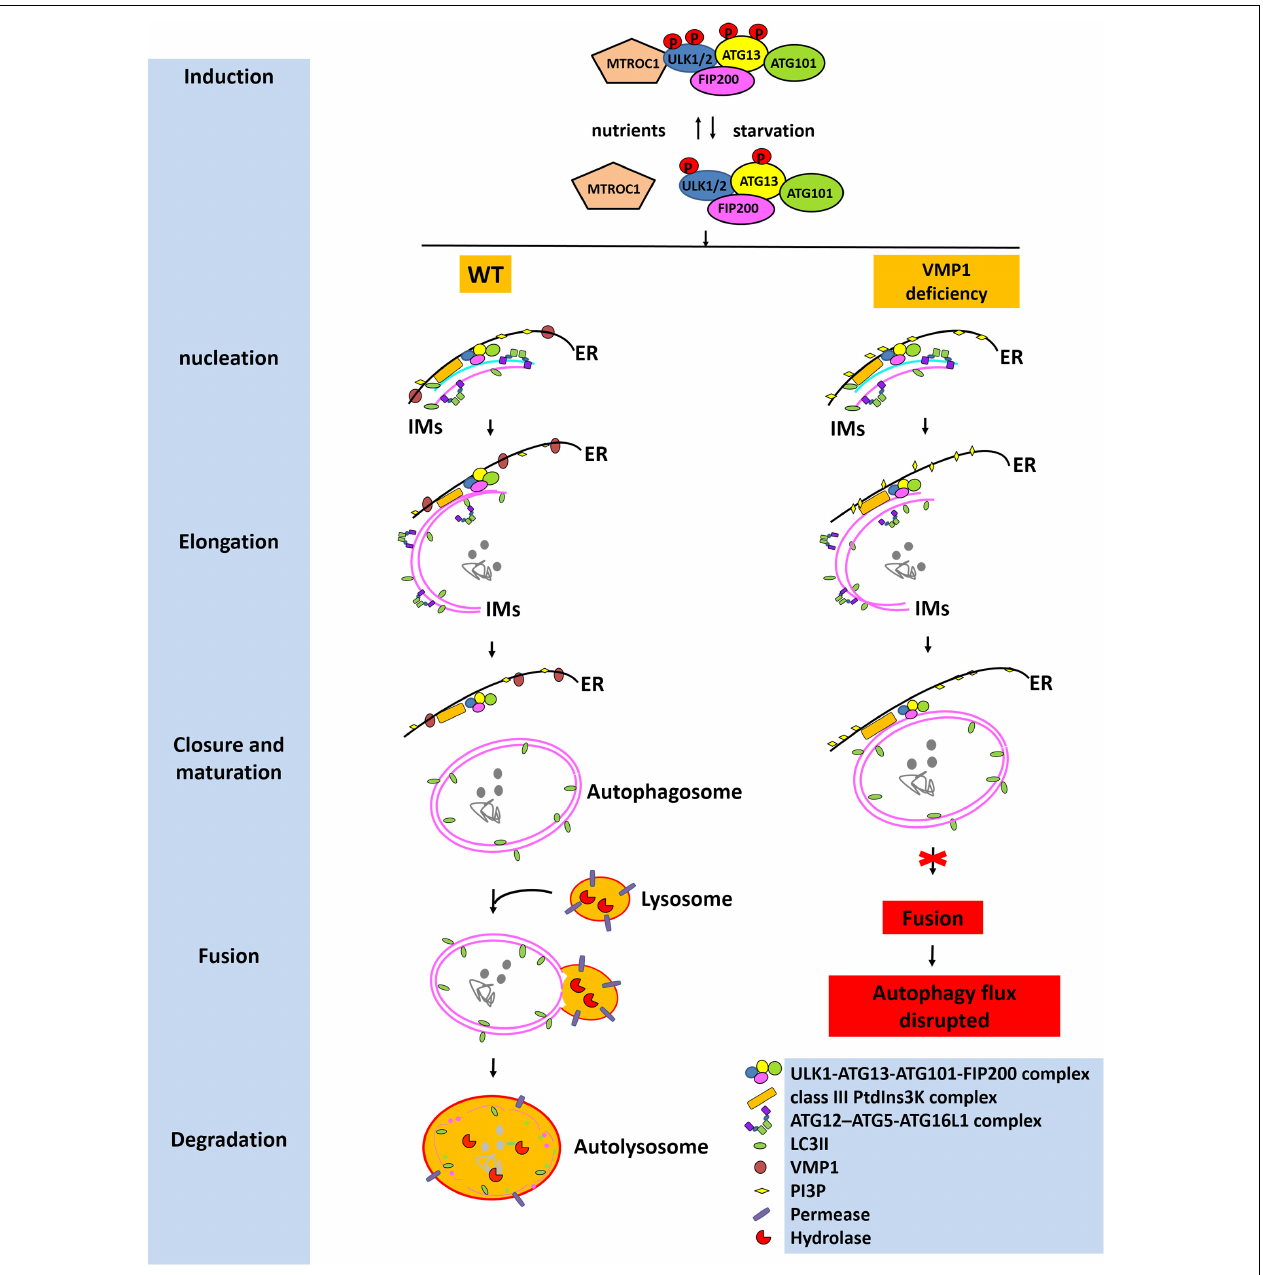
FIGURE 1 | Roles of VMP1 in autophagy. Under starvation, MTORC1 dissociates from the ULK1/2 complex consisting of ULK1/2-ATG13-ATG101-FIP200; then ATG13 and ULK1/2 are partially dephosphorylated by as yet unidentified phosphatases, allowing the induction of macroautophagy. Nucleation and elongation of the IMs are aided by the class III PtdIns3K complex and ATG12-ATG5-ATG16L1 complex. Eventually, the expanding membrane closes around its cargo and separates from the ER to form a mature autophagosome. LC3-II is cleaved from the outer membrane of the autophagosome. The outer membrane of the autophagosome will then fuse with the lysosomal membrane to form an autolysosome. The contents of the autolysosome are then degraded and exported back into the cytoplasm for recycling. However, VMP1 depletion will lead to tight contacts of IMs with ER, inhibiting the departure of IMs from ER, thus resulting in the failed fusion of autophagosome with lysosome. Eventually, the autophagic flux is disrupted. This figure was modified from Figure 2 in Parzych and Klionsky (2014).